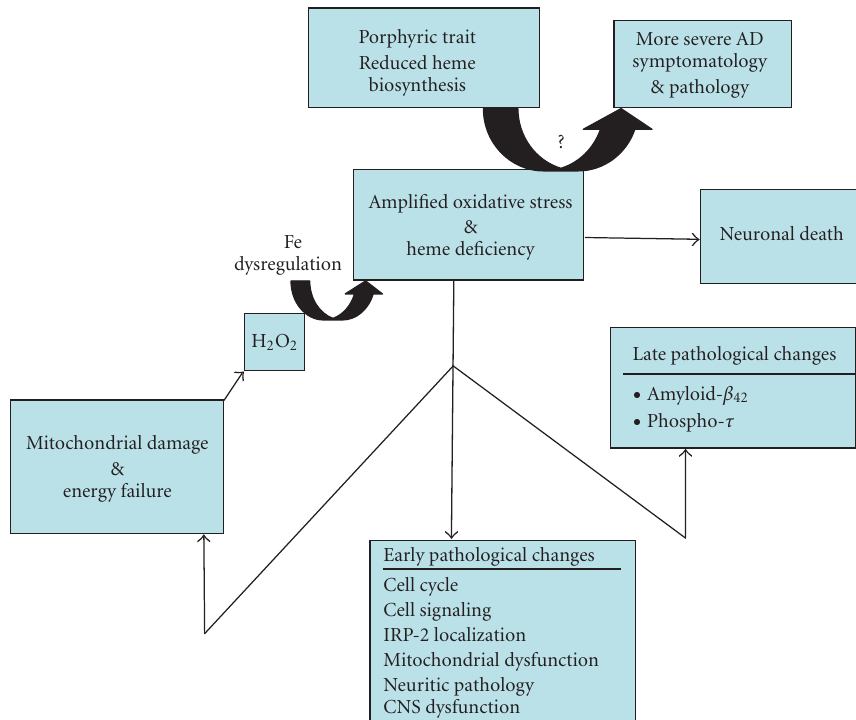
Figure 1: AD and porphyria. Oxidative stress and free radical damage occur early in AD [23]. Disruption in iron homeostatic mechanisms contributes to oxidative damage in AD [24]. A consequence of oxidative stress predicted by the ferric cycle hypothesis is heme deficiency [4, 5]. Moreover, AD-related factors such as accumulation of amyloid- β may limit heme bioavailability [6]. We hypothesize that reduced capacity for cells to synthesize heme, in individuals with the genetic trait for acute hepatic porphyria, contributes to development of heme deficiency (and possibly oxidative stress). AD-related pathological change and neuropsychiatric and behavioral symptoms associated with AD may be more severe in these